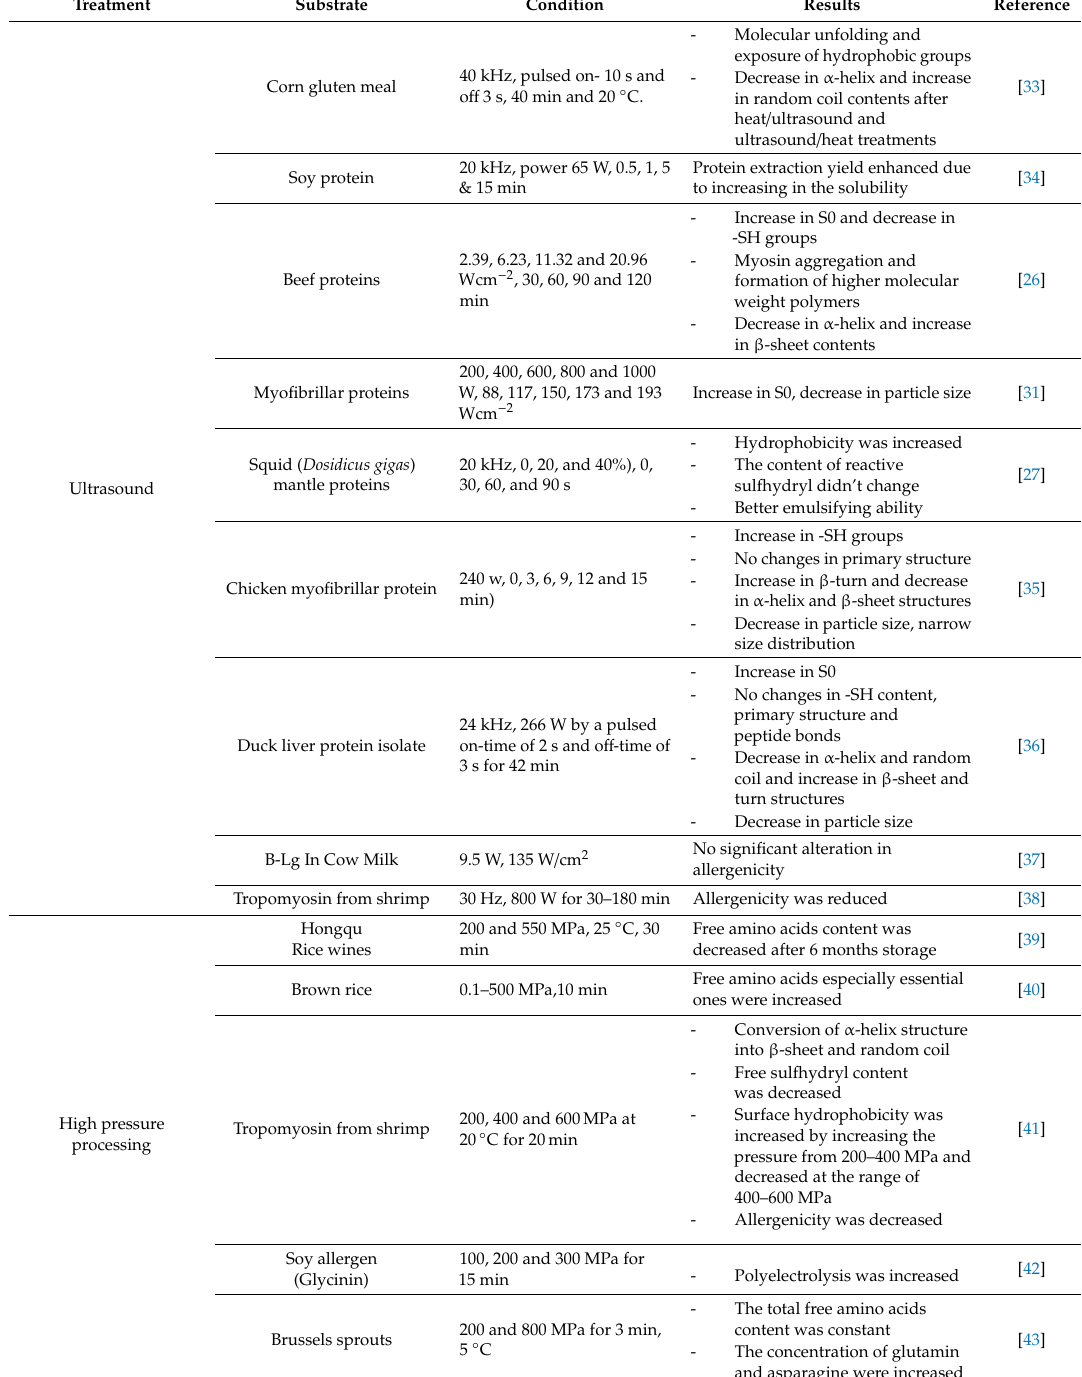
Table 1. E ff ect of non-thermal processing on proteins and amino